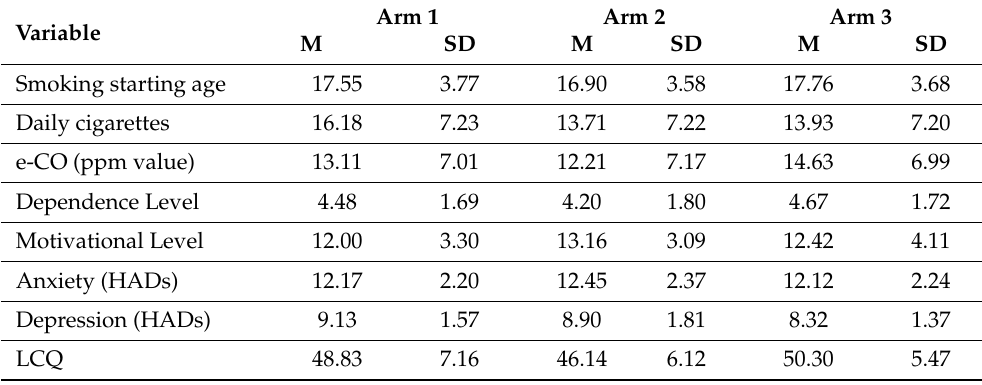
Table 1. Descriptive statistics: participant’s main characteristics at month 12.